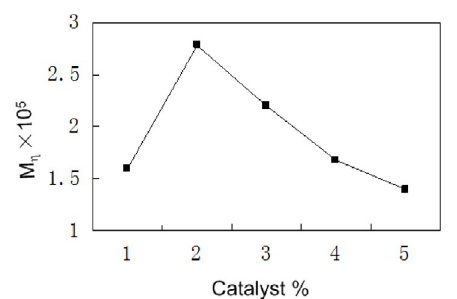
Fig. 2. Effect of catalyzer content on polymer molecular weight Table 3 Effect of catalyst on the conversion of D 4 Table. 3. Effect of catalyst on the conversion of D Amount of catalyzer